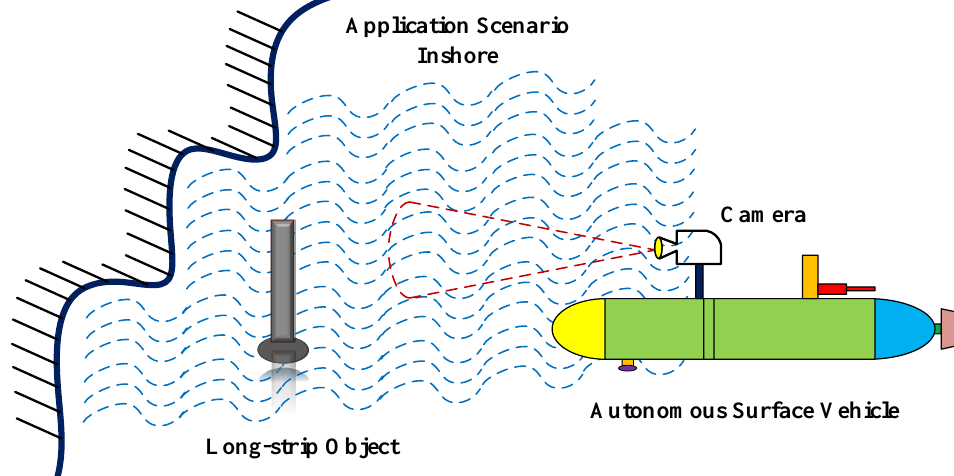
Figure 1. Typical application